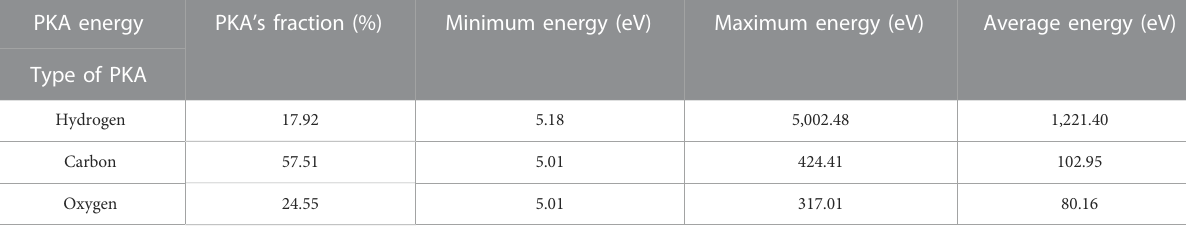
TABLE 2 Information on PKA ’ s minimum, average, and maximum energy by the GAMMATRACK